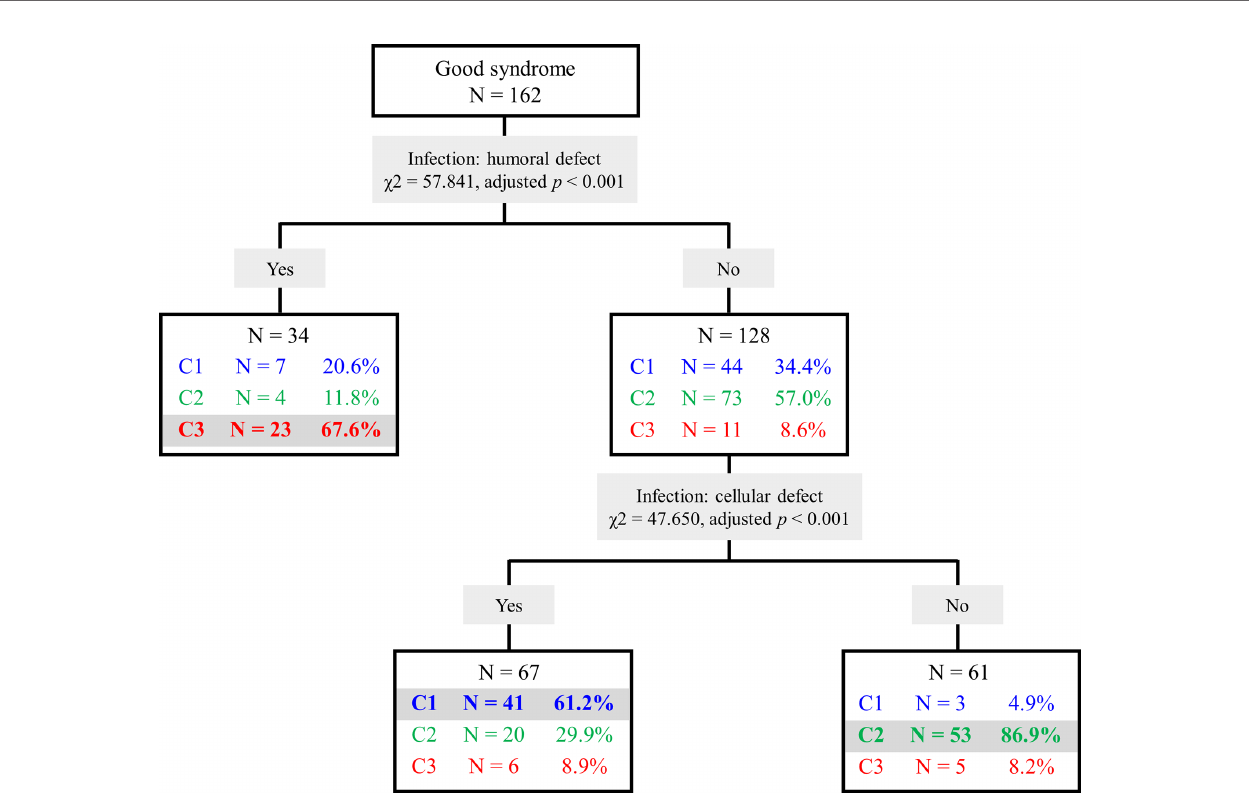
FIGURE 3 | Decision tree of Good syndrome classi fi cation. Cluster 1 (C1), infections related to cellular immunity defects; Cluster 2 (C2), infections related to other immunity defects; Cluster 3 (C3), infections related to humoral and phagocytic immunity